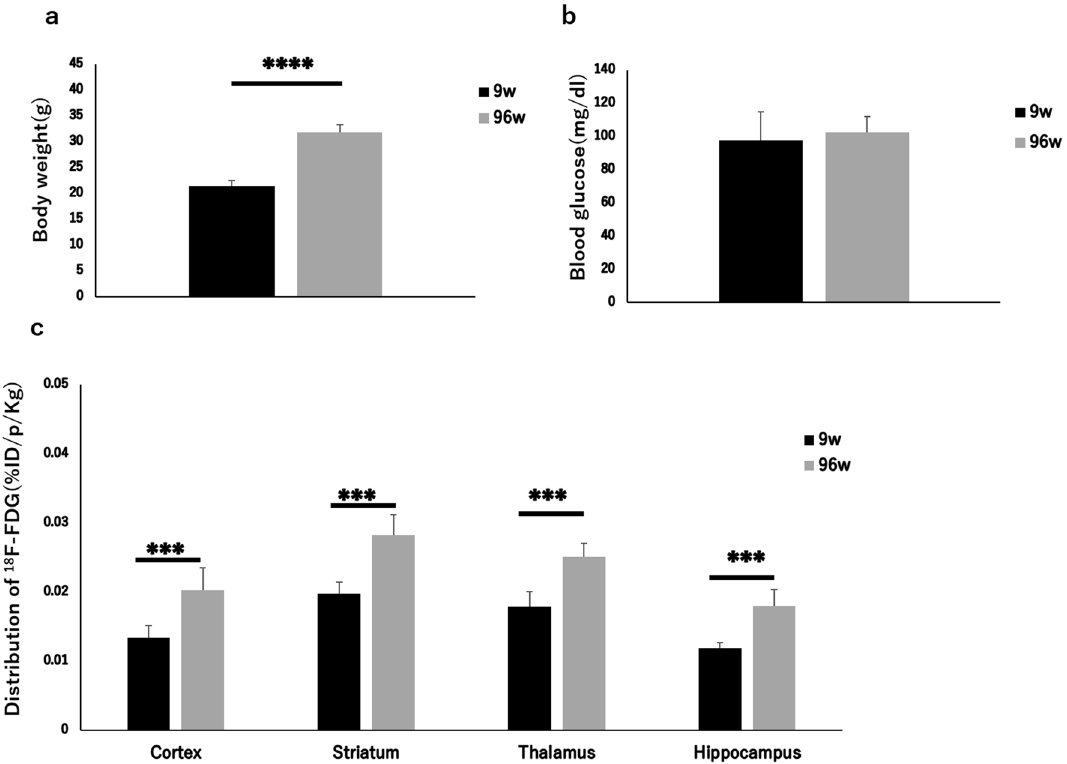
Figure 2. Body weight ( a ), blood glucose concentration ( b ), and 18 F-FDG distribution ( c ) in brains in young and aged control groups. *** P < 0.001, **** P < 0.0001.